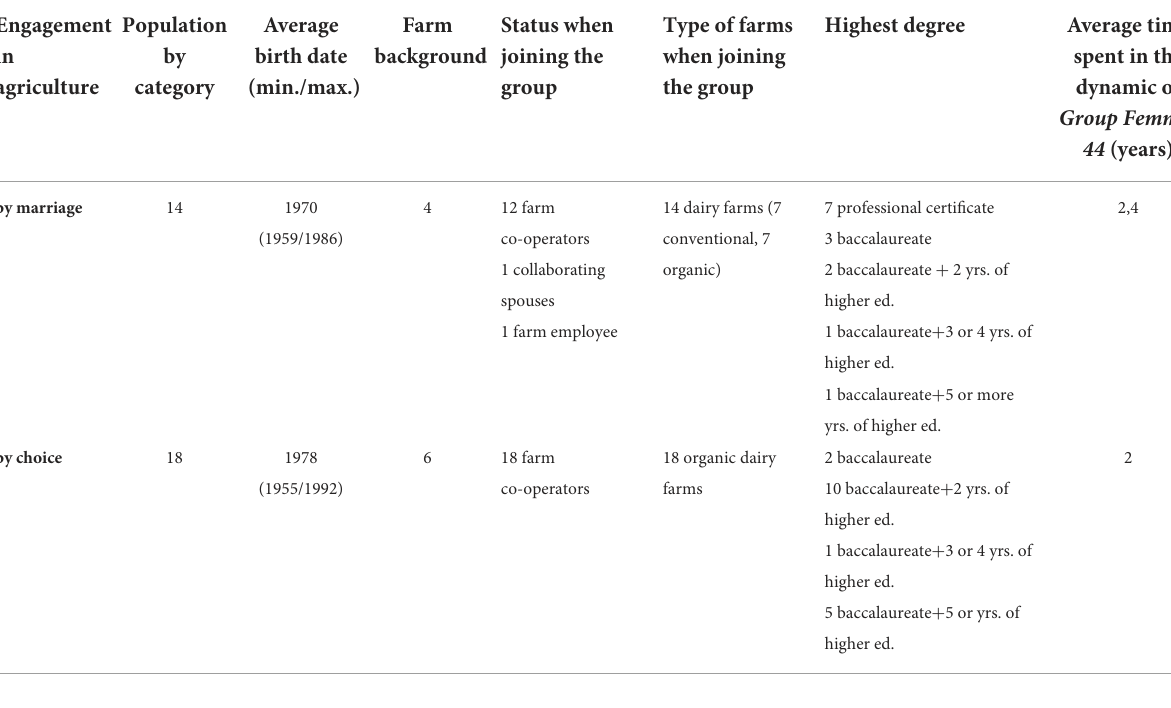
TABLE 2 Main characteristics of the five women farmers